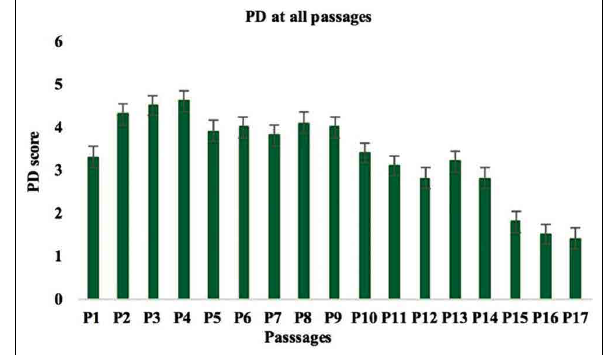
Figure-5: Cell proliferation evaluation of BMMSCs by PD assay. PD was significantly increased on reach P9 then declined until the cells division stopped at P17. Error bars represent Mean ± SE. PD=Population doubling, BMMSCs=Bone marrow mesenchymal stem cells.